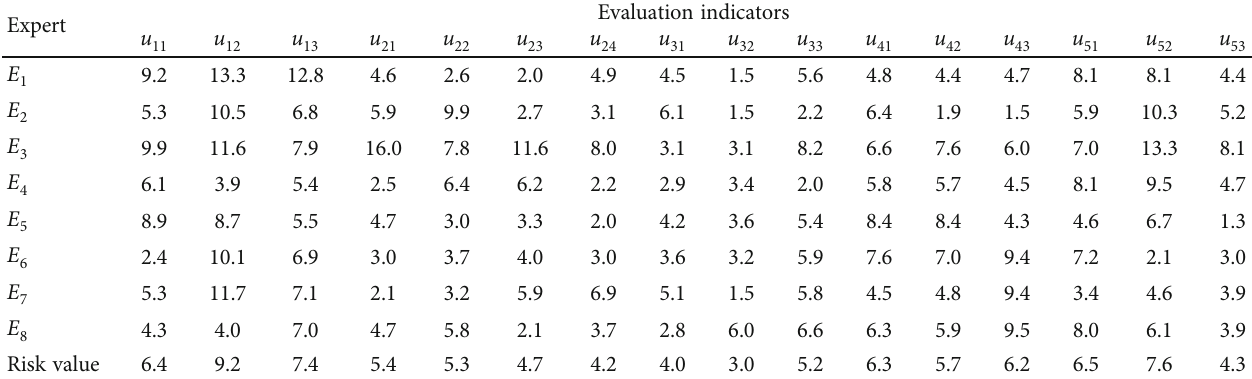
Table 9: Summary of expert evaluation scales.